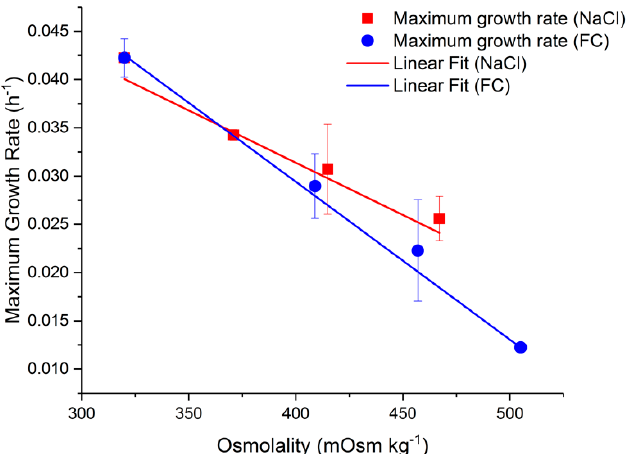
Figure 1. Maximum growth rate of Chinese hamster ovary (CHO) cells as a function of extracellular osmolality. The first point at 320 mOsm kg − 1 represents the control condition. Equation (1) represents the line of best fit for the growth rate from the average Feed C and NaCl dataset presented in Figure 1. This osmolality change is responsible for a 50% reduction in the maximum proliferation rate.